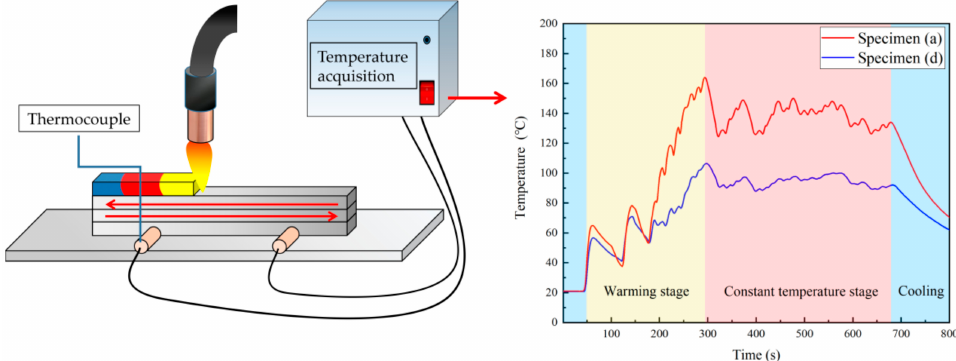
Figure 7. Temperature curve of specimens during